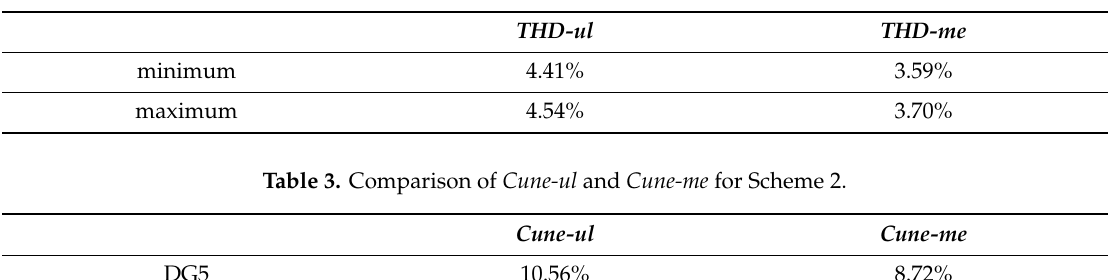
Table 2. Comparison of THD-ul and THD-me for Scheme 2.